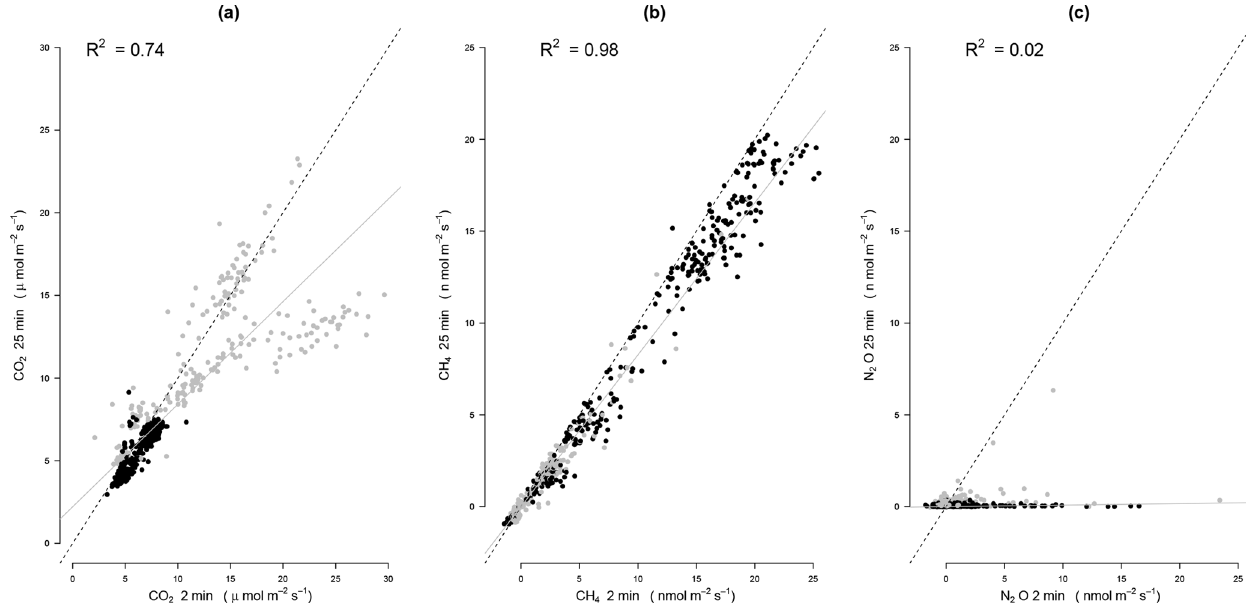
Figure 2. Comparison of 2 and 25min estimations for (a) CO 2 , (b) CH 4 , and (c) N 2 O fluxes. For this, we used measurements made over 25min and recomputed the flux with the first 2min for 2 weeks (from 2 to 9 August in black and from 16 to 25 August in grey) covering the whole range of fluxes during the study period. All fluxes were computed using exponential fit. The dashed line represents the 1 : 1 line while the solid grey line represents the linear regression between 2 and 25min estimations ( R 2 values of these regressions are indicated in each panel).